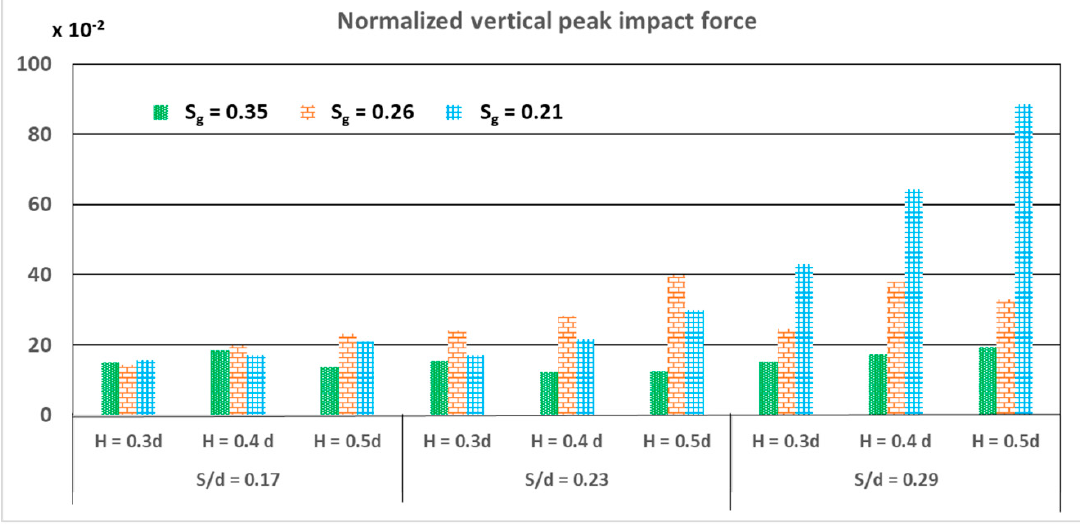
Figure 11. Peak vertical impact force vs. normalized girder spacing for increasing wave heights, H = 0.3d to 0.5d for S/d = 0.17, S/d = 0.23 and S/d = 0.29.